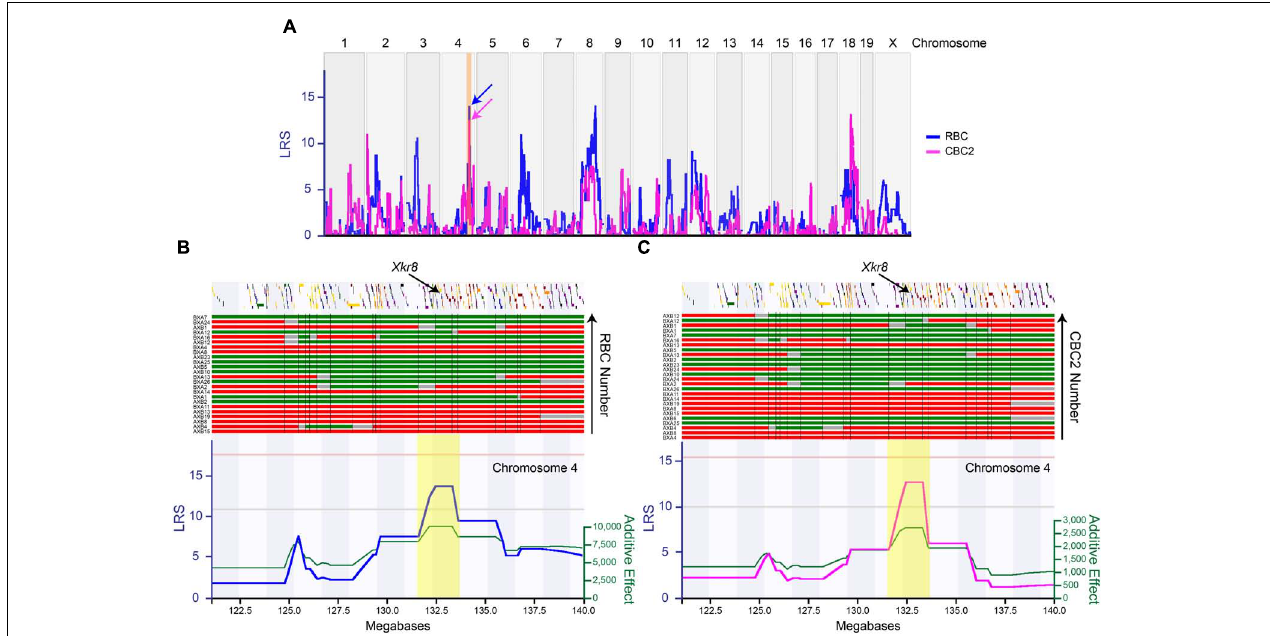
FIGURE 2 | The variation in RBC number (blue trace) and CBC2 number (magenta trace) each mapped to multiple genomic loci (A) , including one shared locus on Chr 4 (arrows in A ). The expanded map of a distal portion of Chr 4 (120–140 Mb, highlighted in orange in A ) is shown below (in B,C ), with the LRS plots now shown separately for each cell type, with RBCs on the left (B) and CBC2s on the right (C) . The position of all genes is indicated across the top, along with the B6/J versus A/J haplotypes across the RI strains (red and green bars, respectively, ordered from bottom to top according to cell number in ascending order). In addition, the additive effect of each A allele (green trace) is shown beneath each LRS trace. The interval interrogated at the Chr 4 locus extended from 131.5 to 133.5 Mb (highlighted in yellow in B , C ), and encompassed 55 genes. Gray regions indicate undetermined haplotype blocks. The position of Xkr8 is indicated, at 132.85 Mb. Horizontal pink and gray lines in both (B,C) indicate the significant and suggestive LRS thresholds determined by permutation testing.